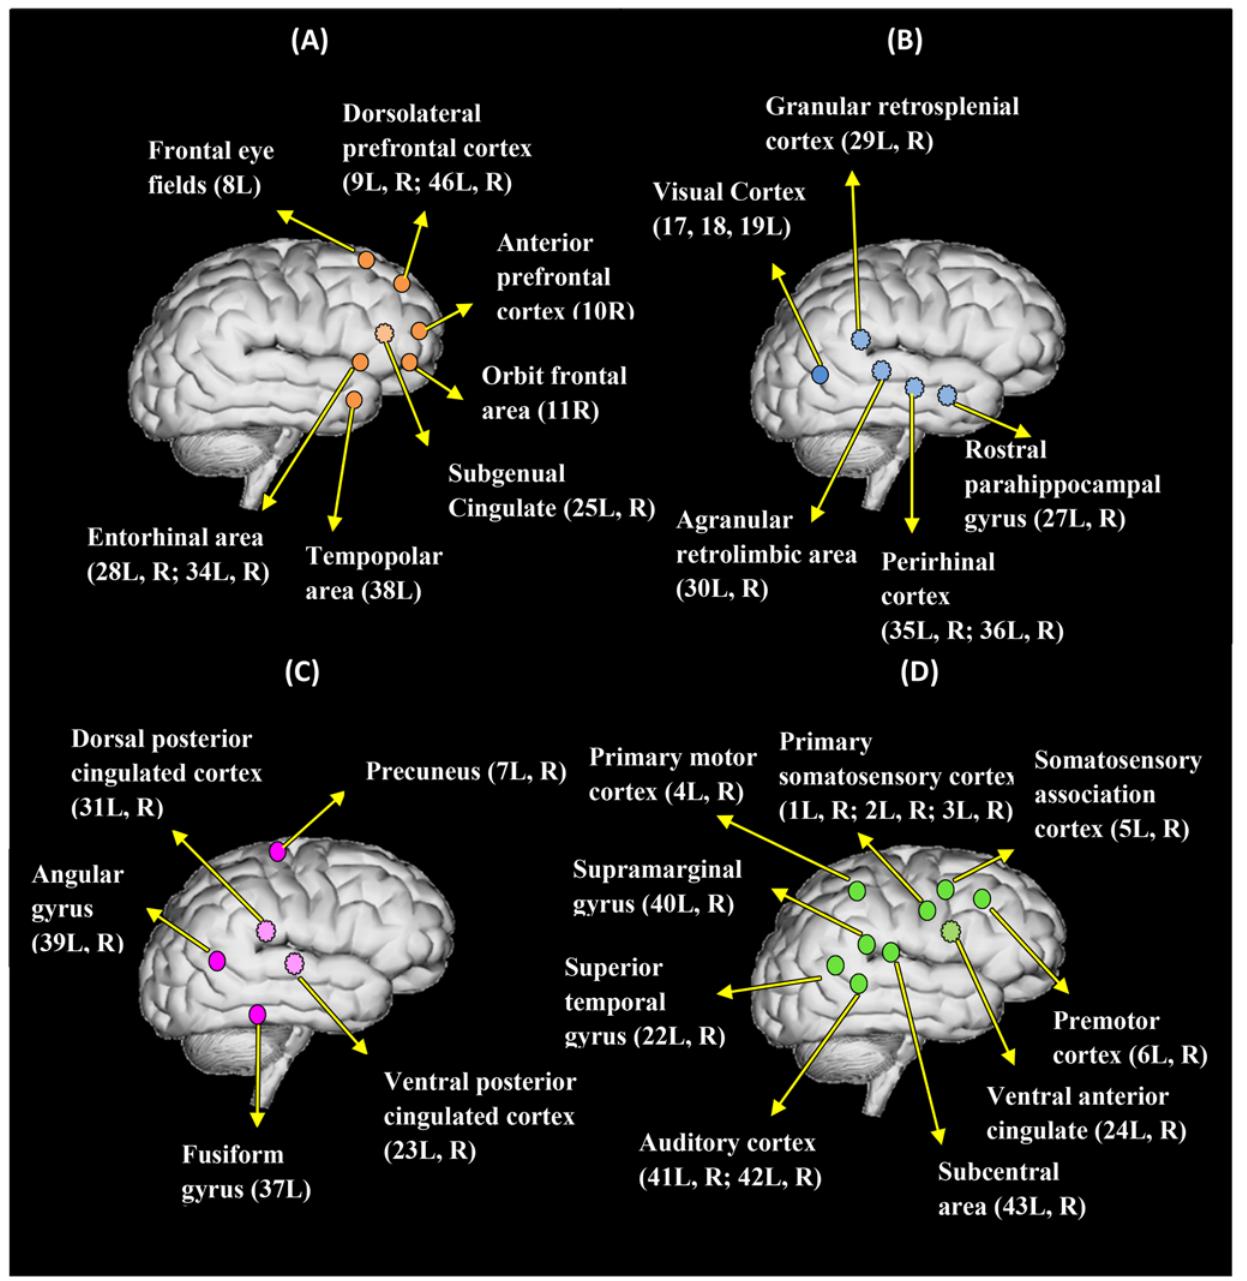
Figure 5. The four common sub-networks (functional clusters) for the WE-IL and the WE-IT conditions. (A)-(D) are hypothetical networks for executing higher-order function, comprehension/memory processing, and speech perception, respectively. The dotted circle indicates a medial surface source, while the solid circle indicates a lateral surface source. The label for each anatomical region includes the Brodmann area name and the laterality information.